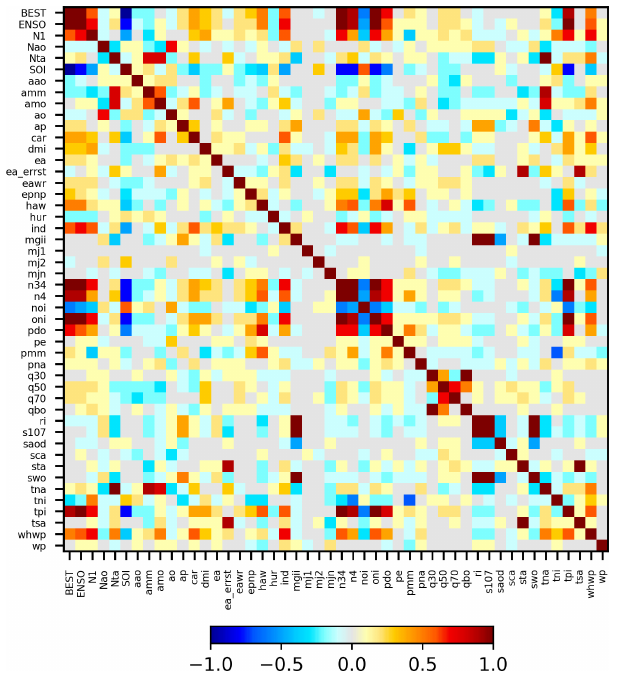
Figure 3. Correlation coefficients between the different teleconnec- tion indices (after seasonal cycle was removed). Note that only one set of MJO indices is included here to minimise the total number of